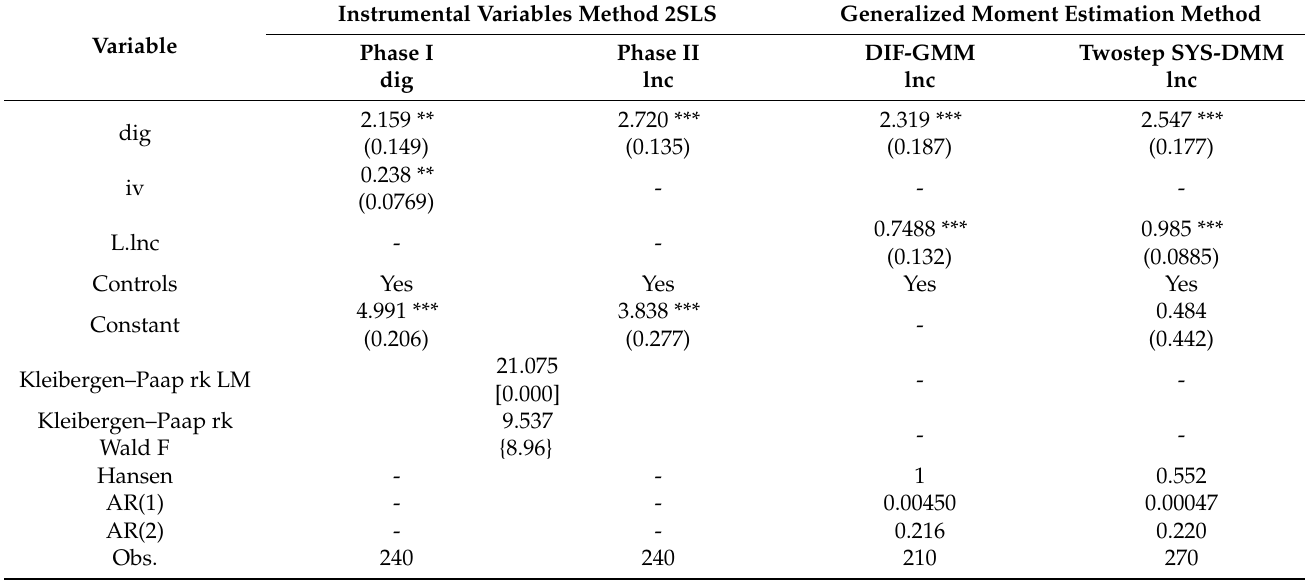
Table 9. Regression results dealing with